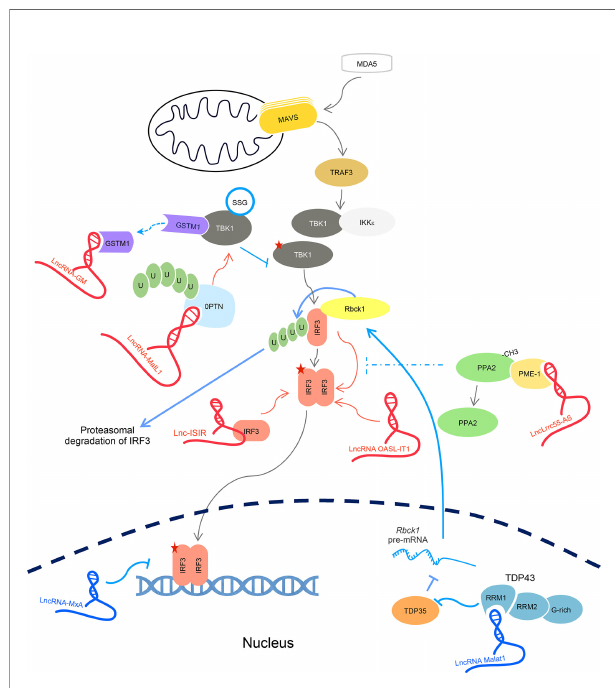
FIGURE 5 | LncRNAs regulate downstream cascades for IFN-I activation. LncRNA-GM targets GSTM1 to disrupt GSTM1-directed S-glutathionylation of TBK1 (SSG), thus promoting TBK1 for its kinase activity. LncRNA MaIL1 targets OPTN to facilitate OPTN-TBK1 binding for TBk1 kinase activity. LncRNA OASL-IT1, lncRNA-ISIR, and lncLrrc55-AS facilitate IRF3 phosphorylation. LncRNA Malat1 downregulates IRF3 abundance by targeting TDP43. LncRNA-MxA inhibits IRF3 binding onto the IFN promoter region. Five-sided star represents phosphorylation modi fi cation. LncRNA in blue represents negative regulators; lncRNA in red is positive regulators for IFN